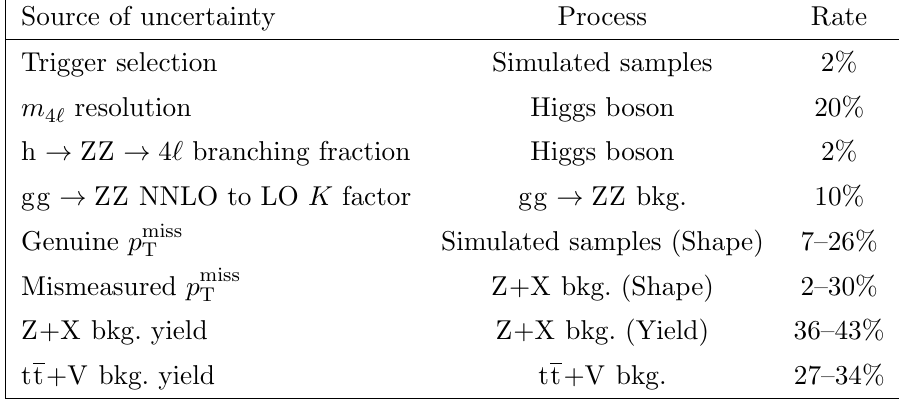
Table 4 . Systematic uncertainties a(cid:11)ecting the h